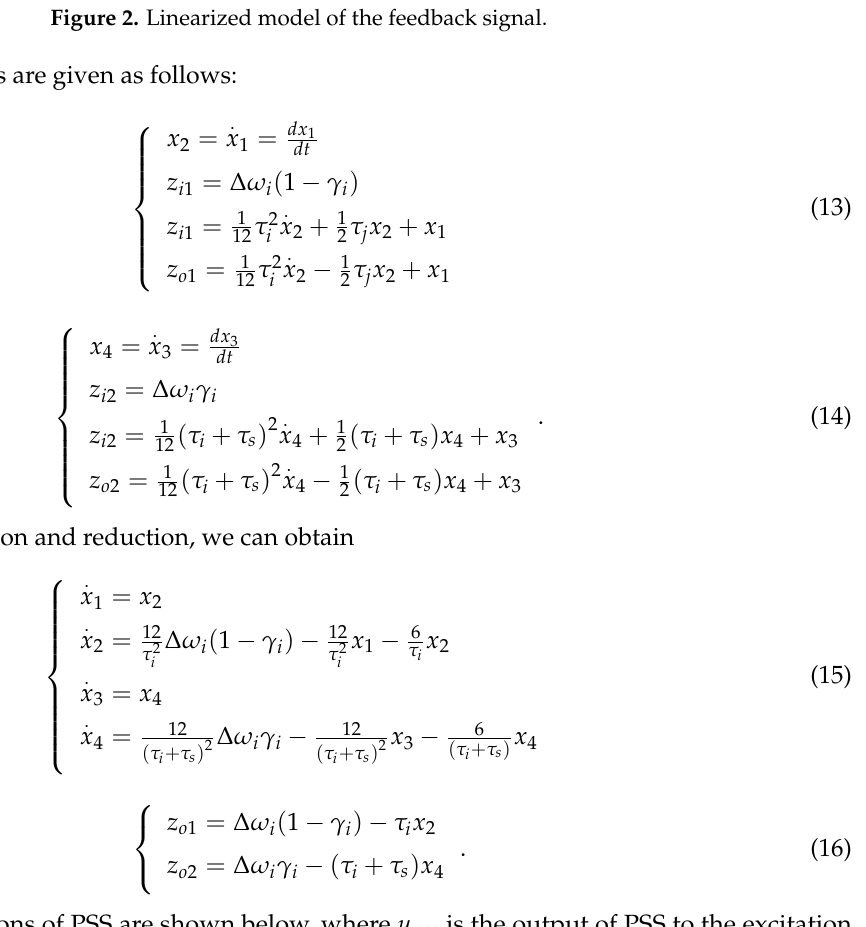
Figure 4. Linearized model of the WADC.